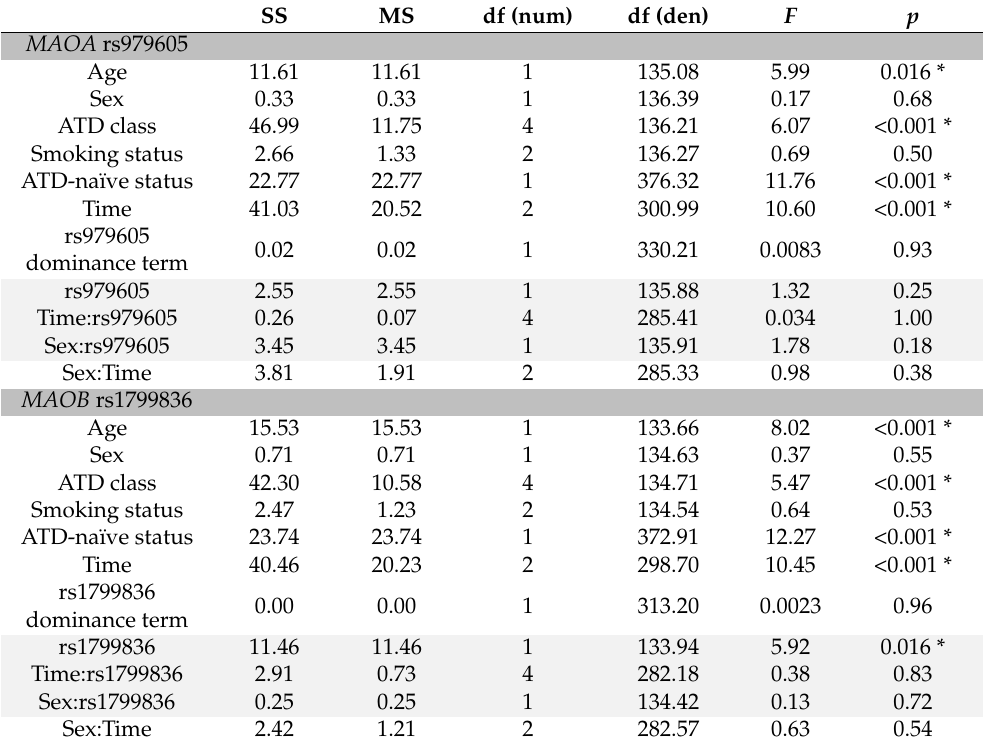
Results for mixed-effects models of the 5HIAA/5HT ratio assessed using the Satterthwaite method. * p < 0.025. ATD, antidepressant drug; den, denominator; df, degrees of freedom; F , F statistic; MS, mean squares; num, numerator; p , p -value; SS, sum of squares.